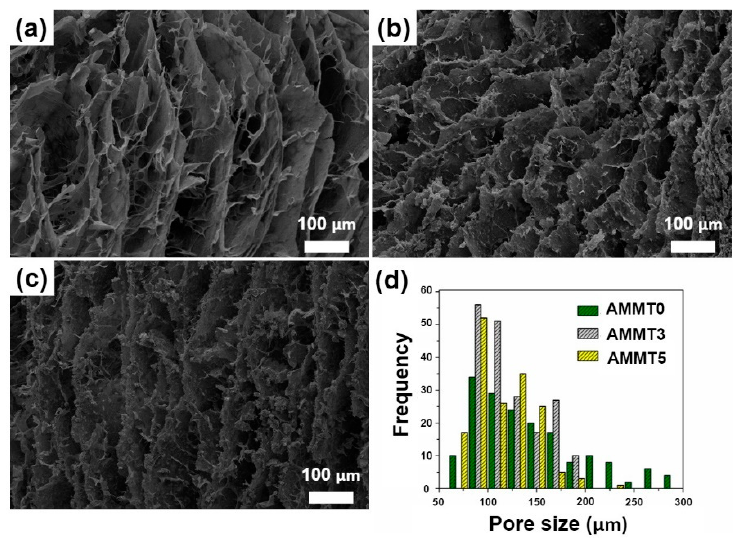
Figure 4. Cross-sectional SEM images and pore size distribution of ( a ) AMMT0, ( b ) AMMT3, and ( c ) AMMT5 samples, ( d ) pore size distribution of each specimen (SEM images were taken in 300× magnification, Scale bar: 100 µm).